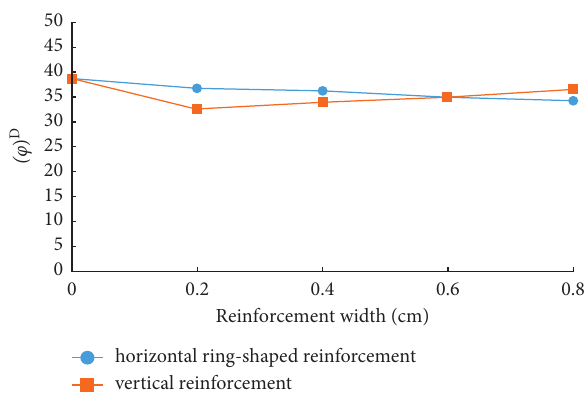
Figure 19: Relationship curves of the internal friction angle and the reinforcement width of reinforced